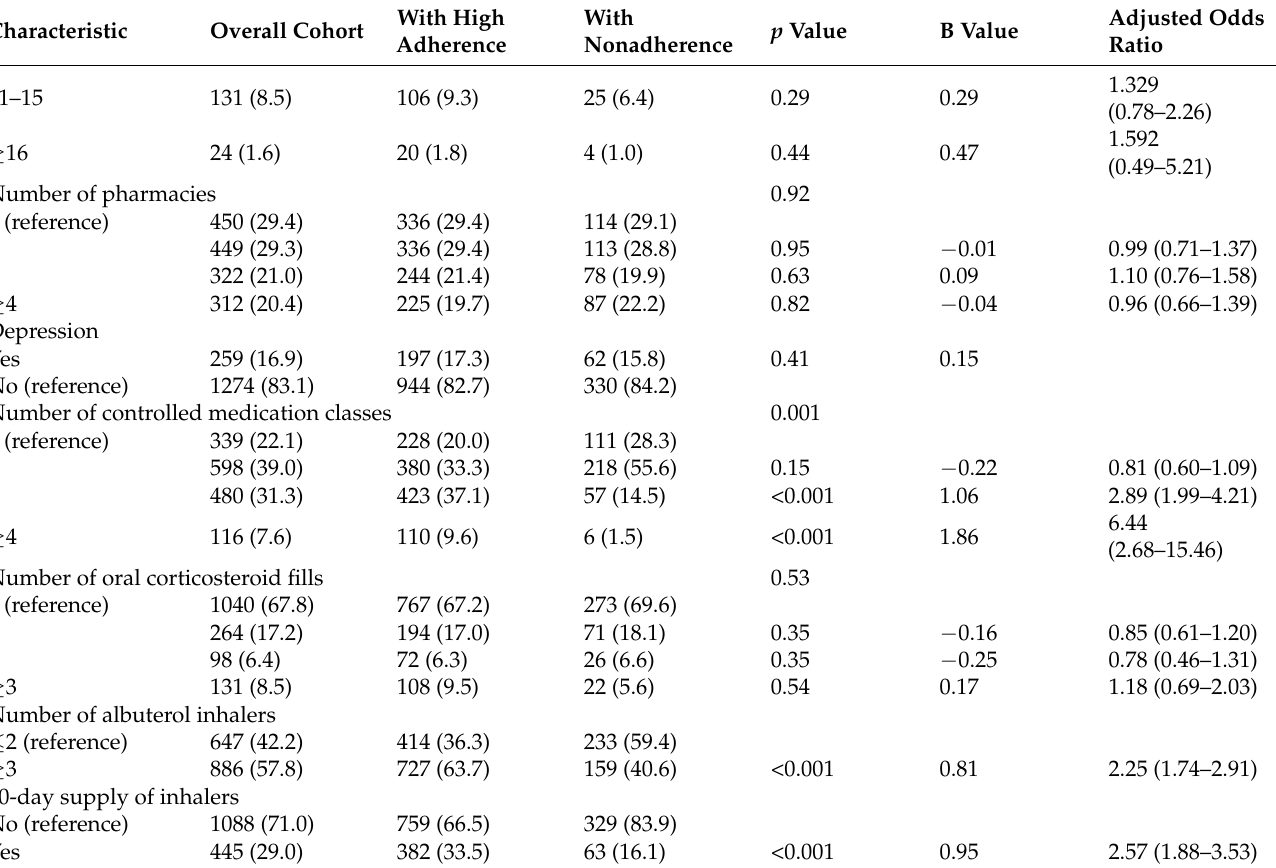
Figure 3. Proportion of patients with at least 1 combination inhaler. Abbreviations: LABA, long- acting β2 -agonists; LAMA, long-acting muscarinic antagonists; ICS, inhaled corticosteroid.